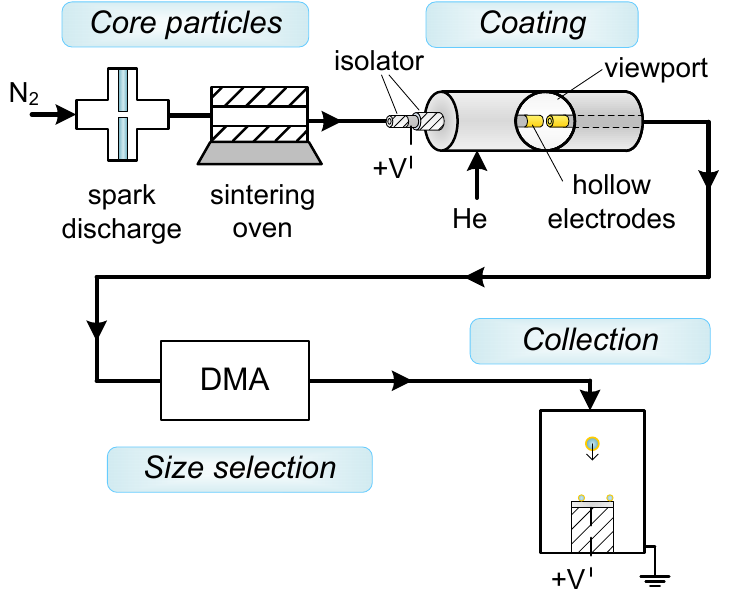
Figure 2. Coating setup comprising a particle source, coating zone, differential mobility analyzer (DMA) and an electrostatic precipitator